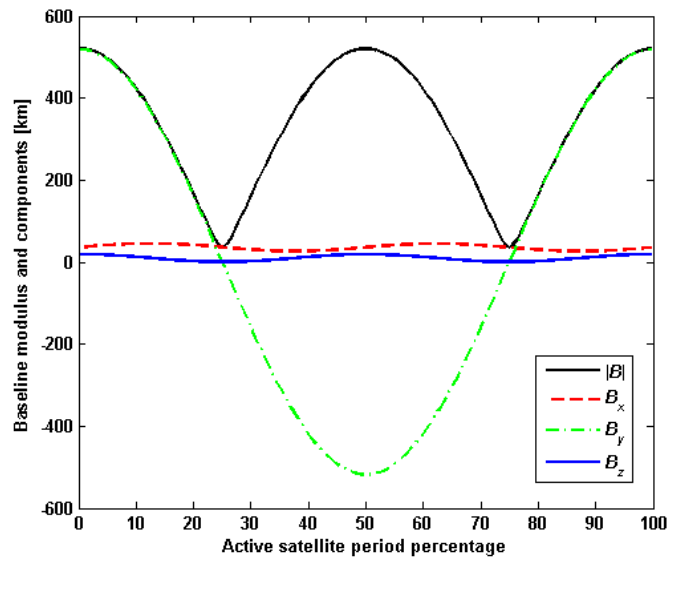
Figure 6. Baseline length (absolute value) and components in the active satellite orbital reference frame versus the orbital period percentage. One orbit is considered for the sake of figure